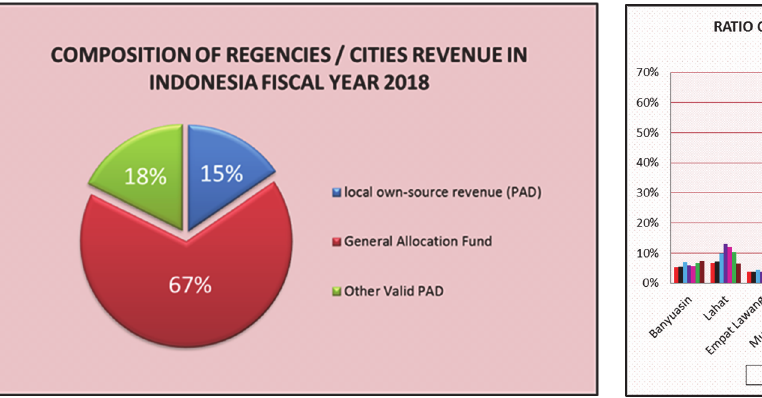
Fig.1. Composition of Regencies / Cities Revenue in Fig. 2. Ratio of Regencies / Cities Independence in